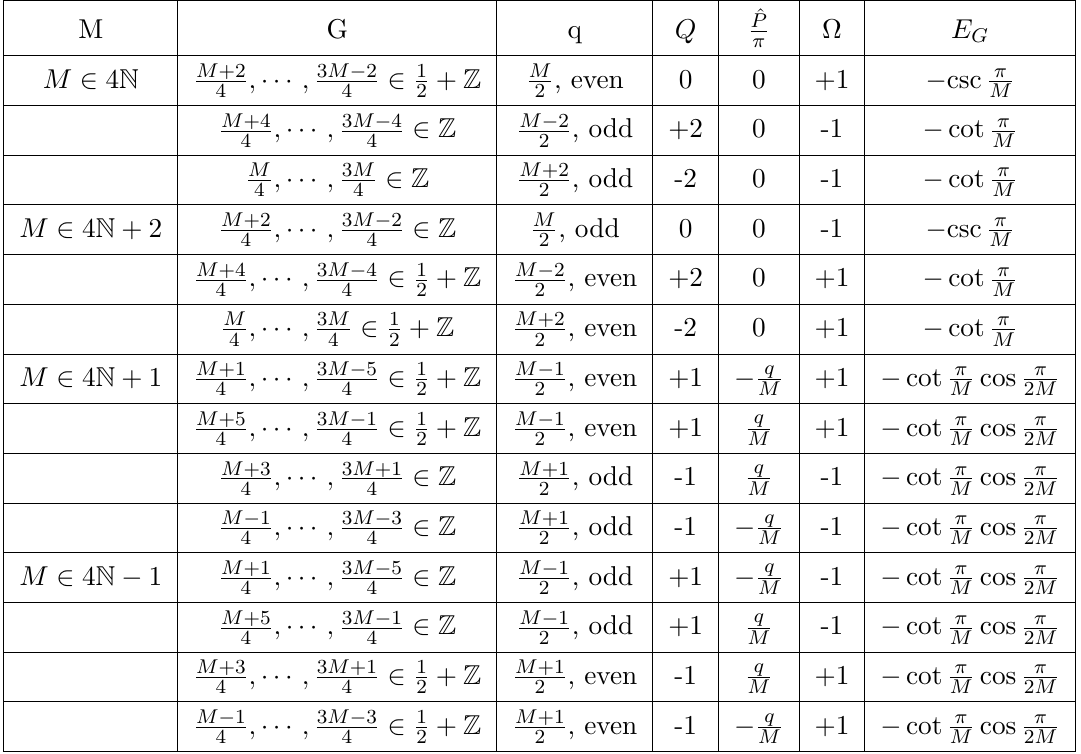
Table 1 . Momentum modes contributing to the ground state(s) in both Ω = ± 1 sectors for fixed M , together with values of q, Q, ˆ P/π , and energy in each